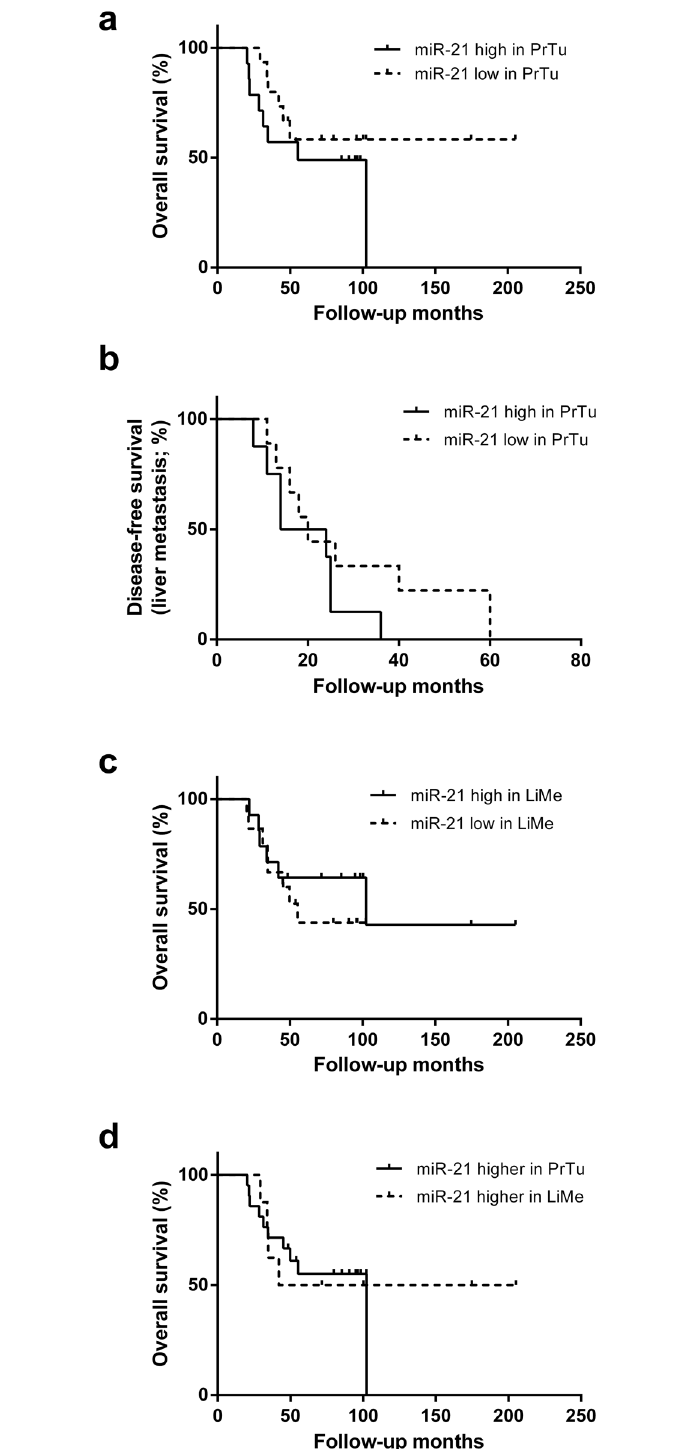
Fig 2. Correlation of miRNA-21 to patient follow-up. Disease-free survival with regard to liver metastasis (LiMe) and overall survival illustrated with the Kaplan-Meier method. (a) Comparison of overall survival between a miRNA-21 high and low expression group in colorectal carcinomas (PrTu). There is a trend towards shorter survival with higher miRNA-21 levels, although not significant (p = 0.27). (b) The patients with metachronous LiMe are sub-divided into a high and low miRNA-21 expression group in PrTu. By trend, high